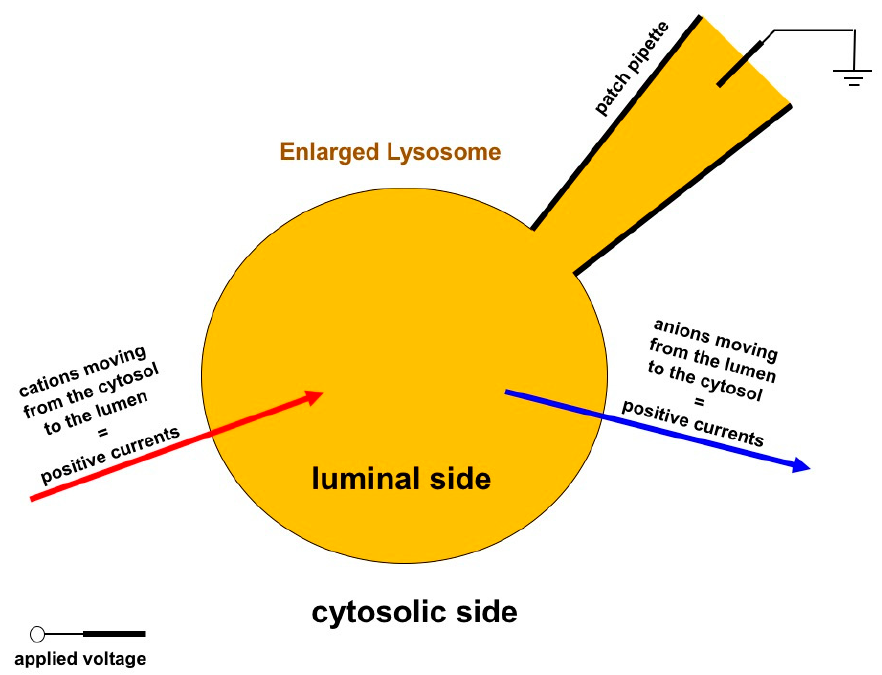
Figure 4. Cartoon of the patch-clamp recording configuration on enlarged lysosomes and current convention. The patch clamp technique is applied in the whole-lysosome configuration after lysosome enlargement by treatment with vacuolin-1. Positive currents correspond to the movement of cations from the cytosolic to the luminal side of the lysosome or to the opposite movement of anions.